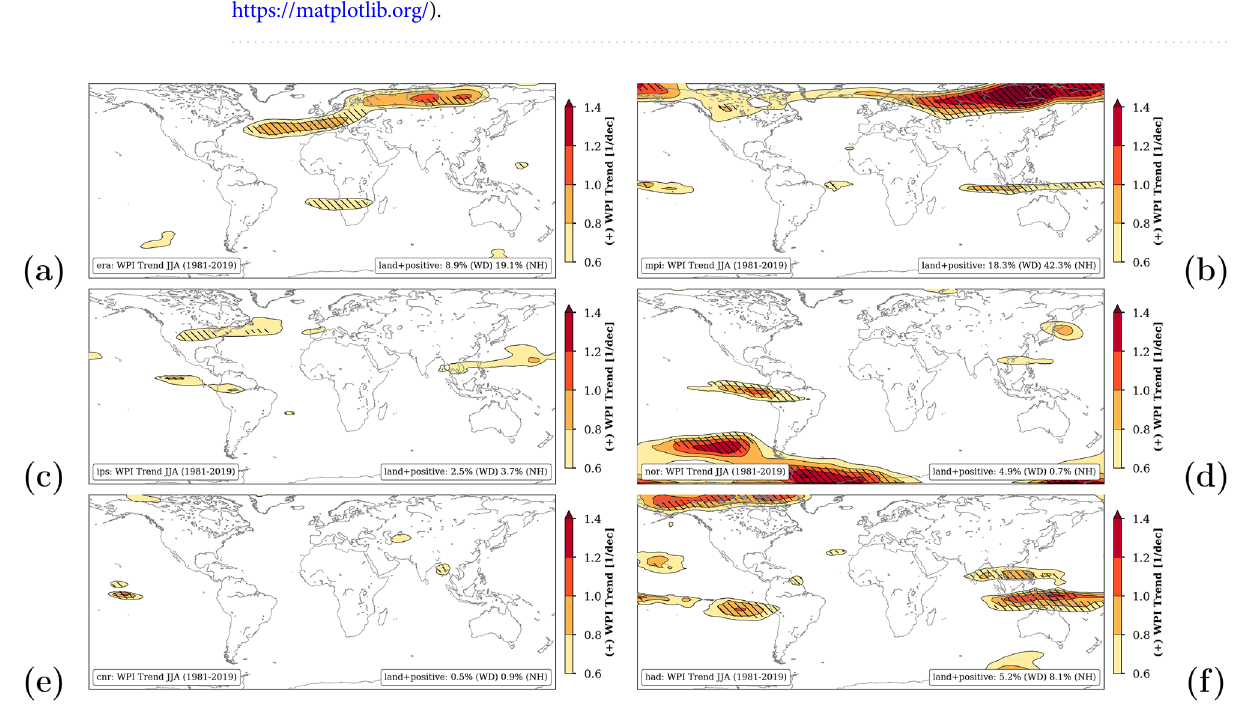
Figure 9. Global trend patterns of the weather persistence index (WPI) in Jun–Aug from 1981 to 2019 processed from ERA5 reanalysis data and selected CMIP5 simulations: ERA5 ( a ), MPI-ESM-MR ( b ), IPSL- CM5A-MR ( c ) and NorESM1-M ( d ) CNRM-CM5 ( e ) HadGEM2-ES ( f ). Only positive and significant trends ( p -value < 0.05 using a two-sided t -test) are shown as contours and hatched, respectively. The values in the lower right box represent the percentage of grid cells over land showing positive trends larger than + 0.6dec globally (WD) and > 30 ◦ N (NH). The maps were created by using python3-mpltoolkits.basemap (version 1.2.1, https:// matpl otlib. org/ basem